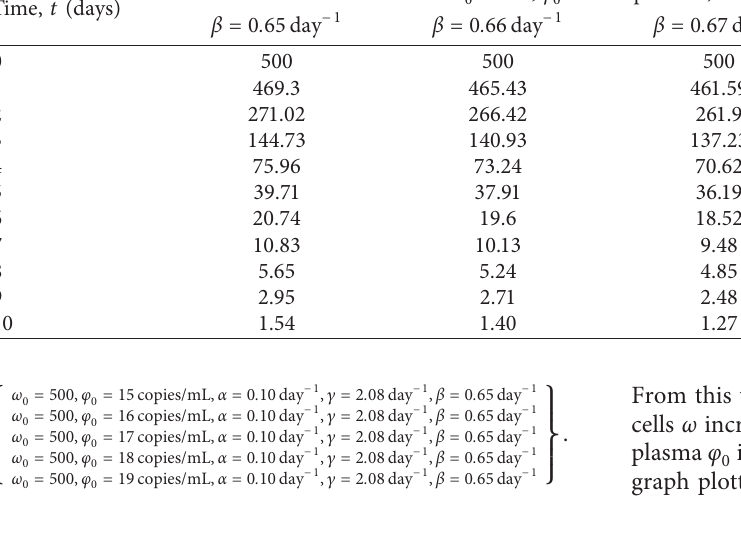
Table 3: The number of infected cells ω for different values of time t and rate of loss of virus producing cells β with ω